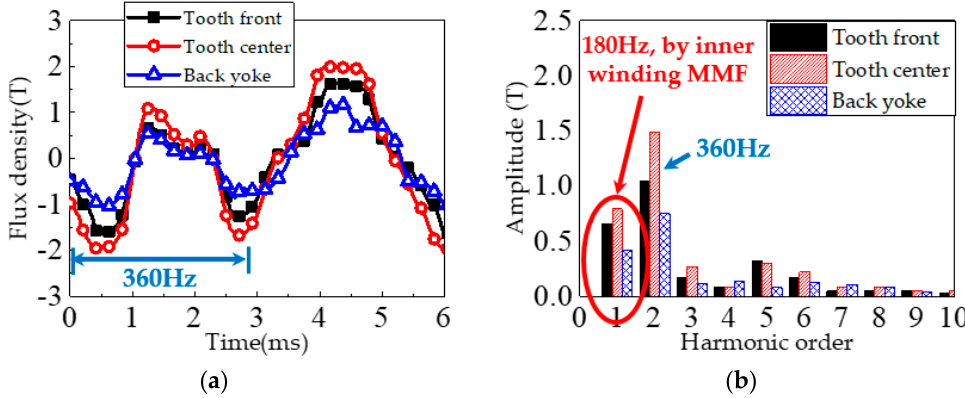
Figure 5. Variation of the radial magnetic flux densities with time at the front of tooth, center of tooth, and back yoke in the outer stator. ( a ) Waveform and ( b ) Time harmonic spectra.